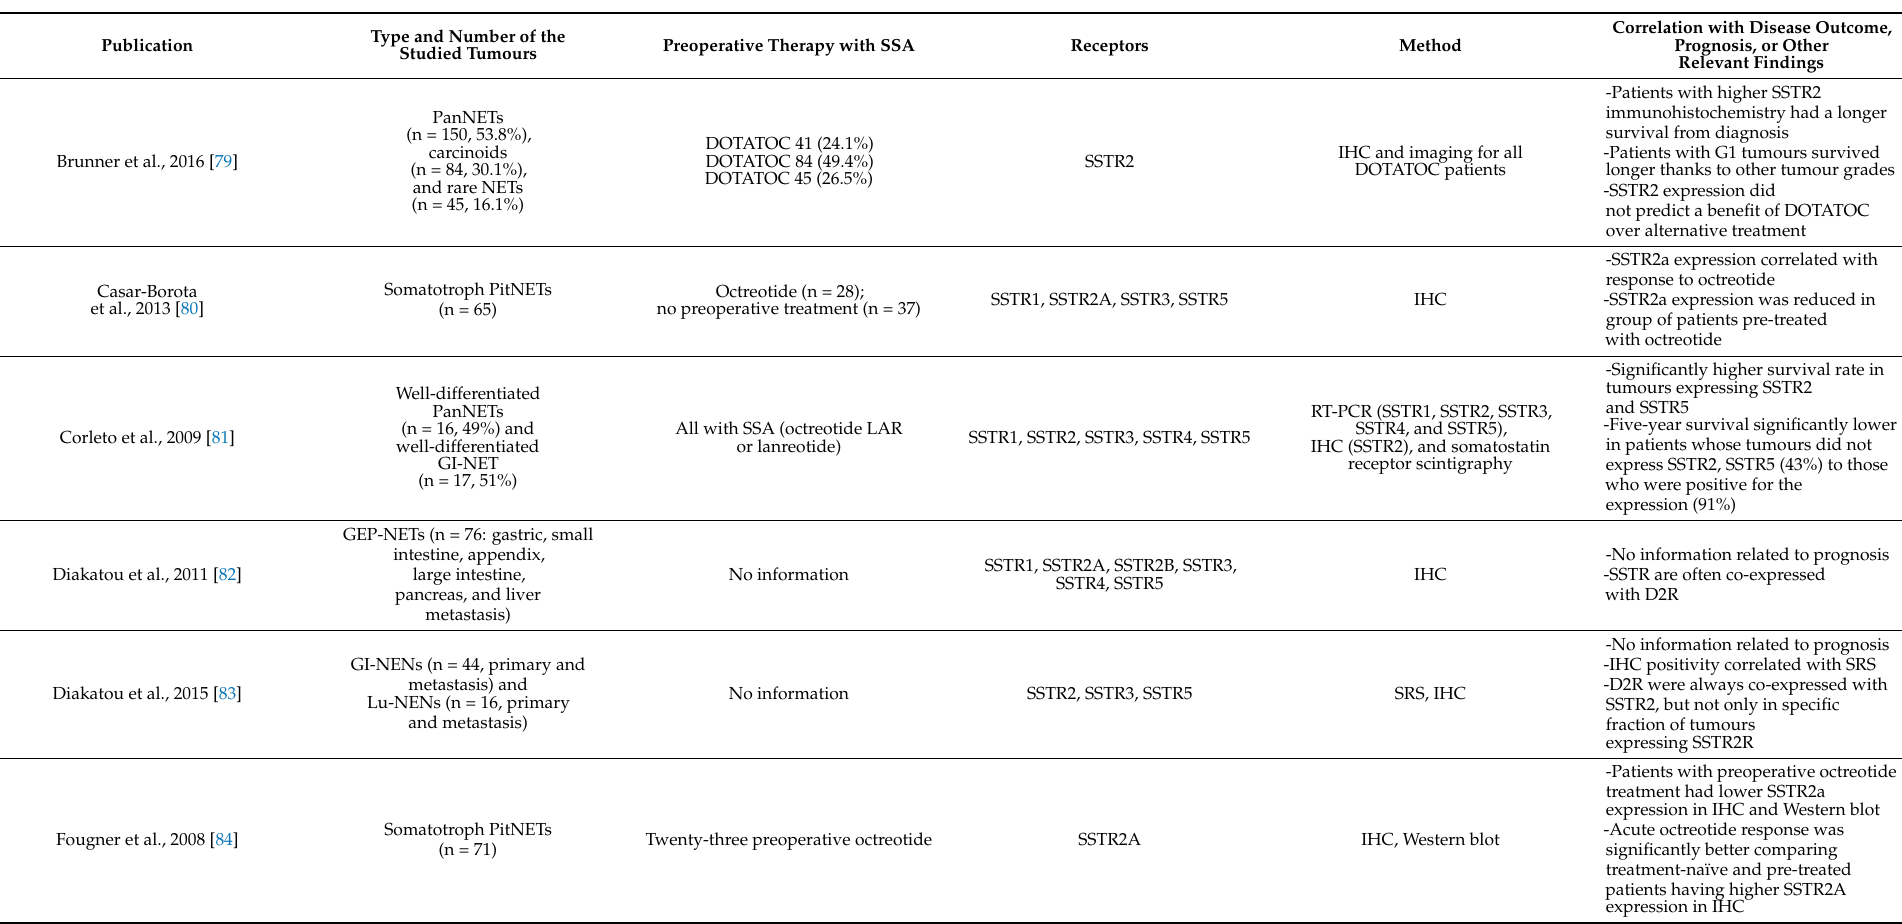
Table 1. Studies investigating SSTR expression in NETs and the potential impact of SSTR expression on disease